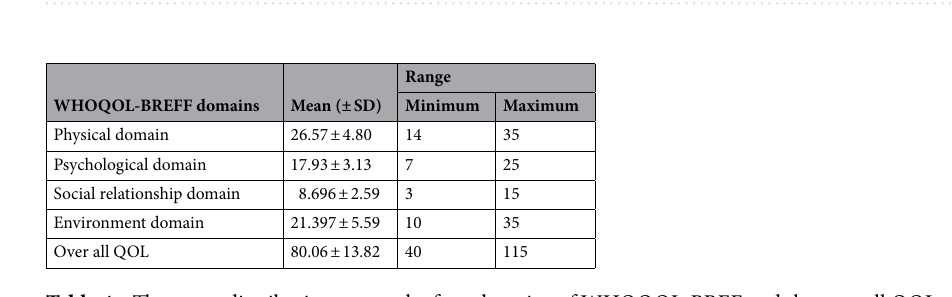
Table 4. The mean distribution across the four domains of WHOQOL-BREF and the over all QOL of caregivers of patients with mental illness, DRH,